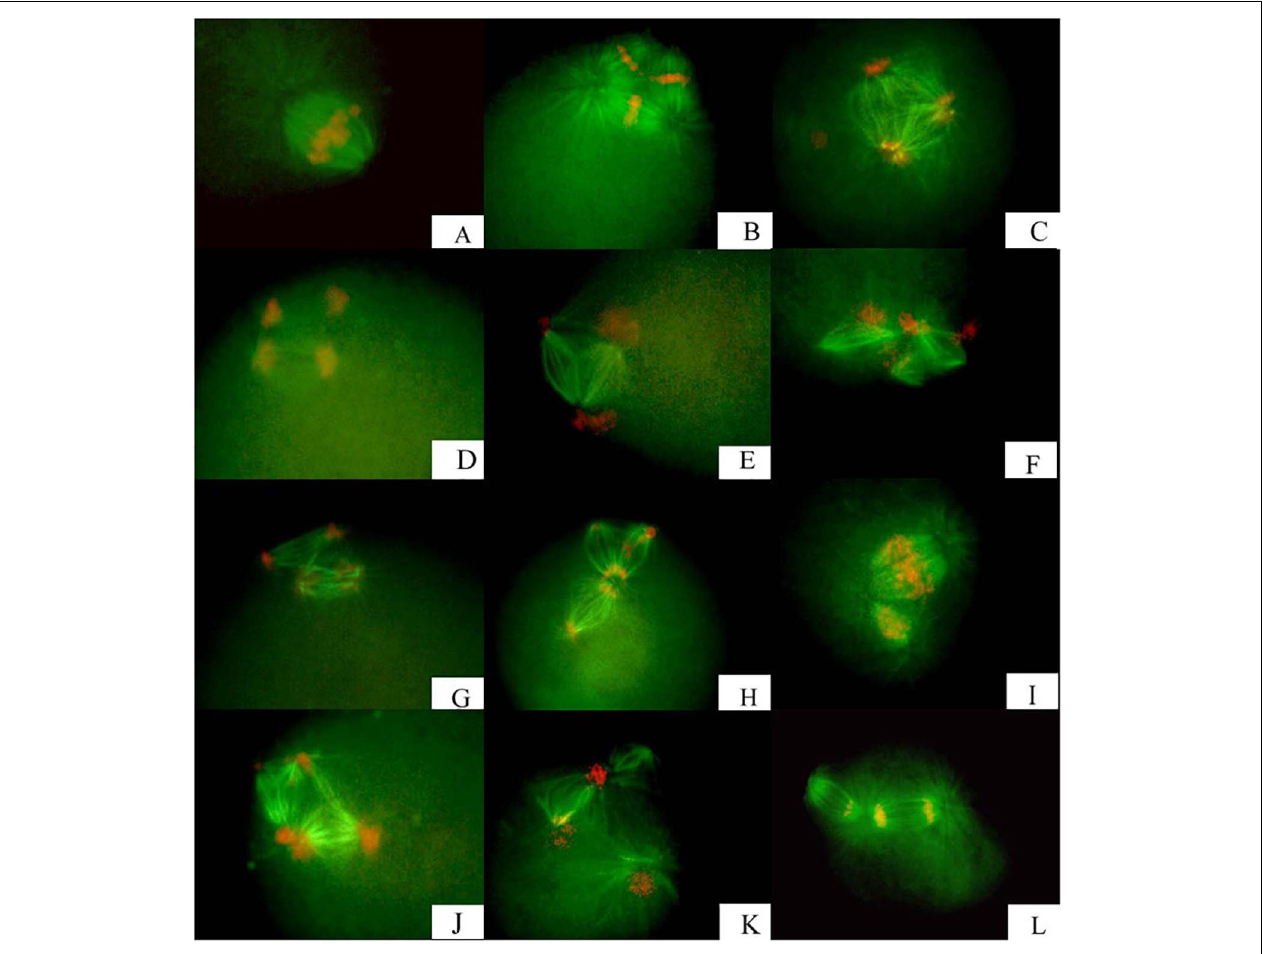
FIGURE 1 | Meiotic apparatuses assembling and correlated chromosome segregation observed in fertilized eggs from triploid Zhikong scallop, following inhibition of polar body I. (A) Bipolar segregation with bipolar spindles. (B,C) Tripolar segregation with tripolar spindles. (D,E) Separated bipolar segregation with two bipolar spindles. (F–L) Unclassified segregation with several types of spindles at low frequency.